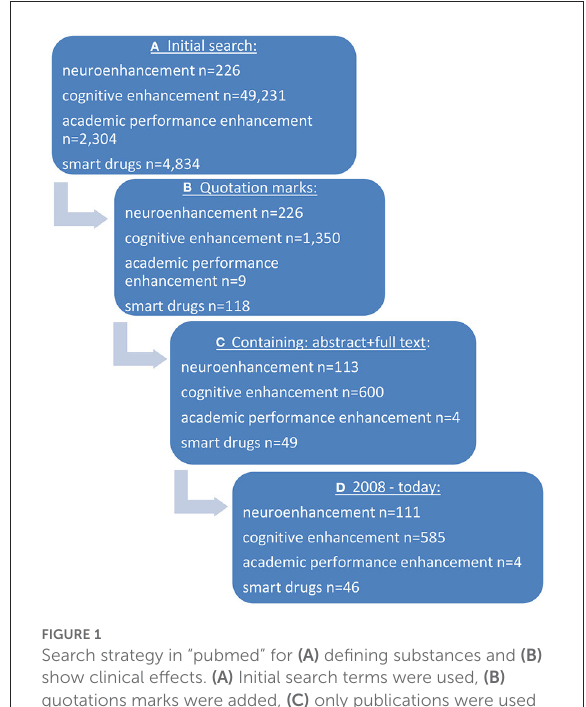
FIGURE1 Search strategy in “pubmed” for (A) defining substances and (B) show clinical effects. (A) Initial search terms were used, (B) quotations marks were added, (C) only publications were used with abstracts and full text, (D) only publications published later than 2007 were considered.